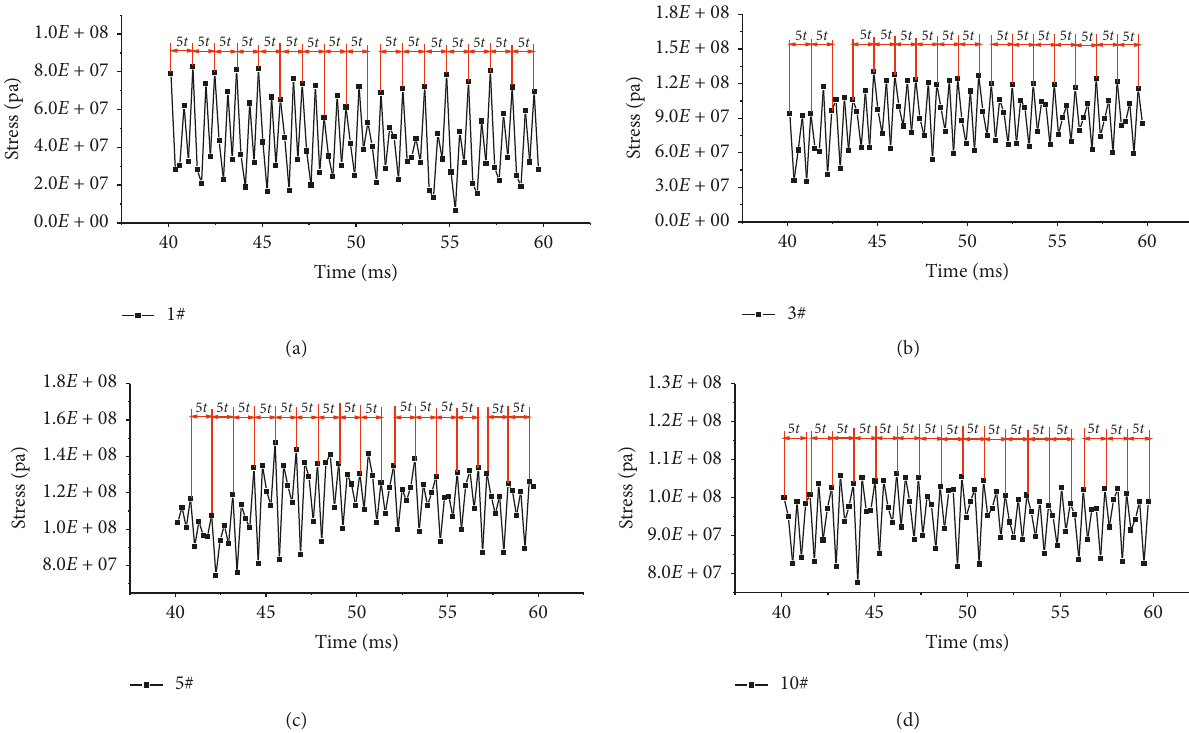
Figure 6: Stress fluctuation cycle period of the representative elements ( α � 10 ° , H � 10mm, and V � 1.36m/s): (a) 1# element; (b) 3# element; (c) 5# element; (d) 10#